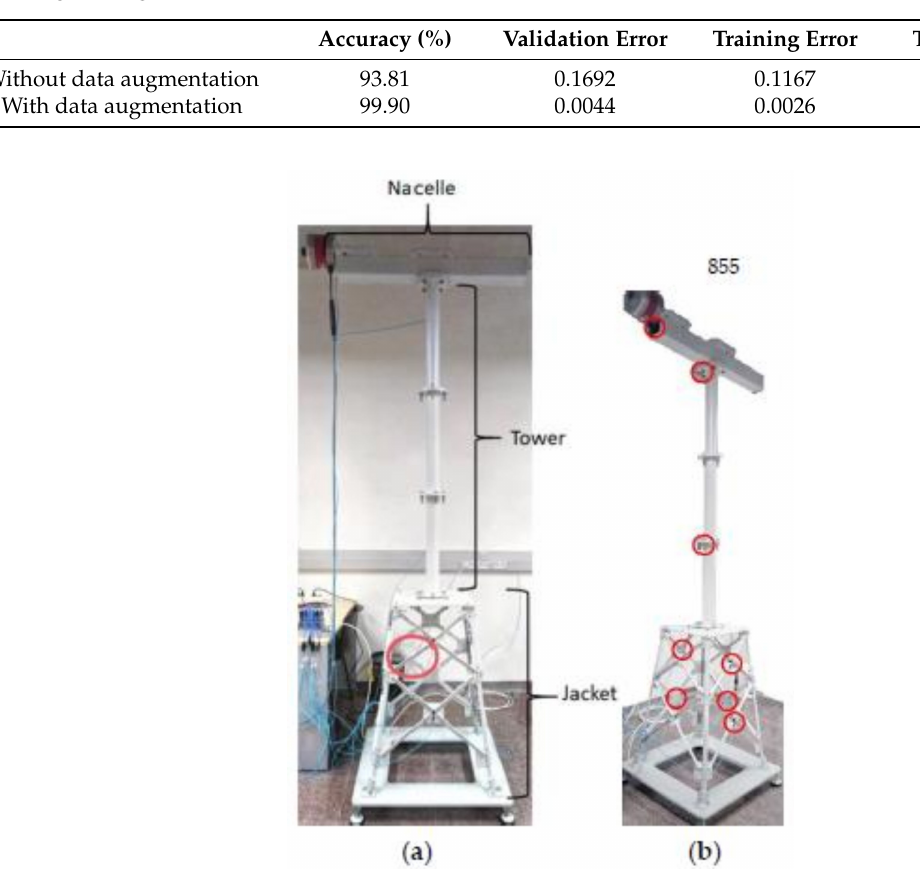
Table 9. Comparison of accuracy, validation error, training error, and training time when using data augmentation or when using the original dataset [120].